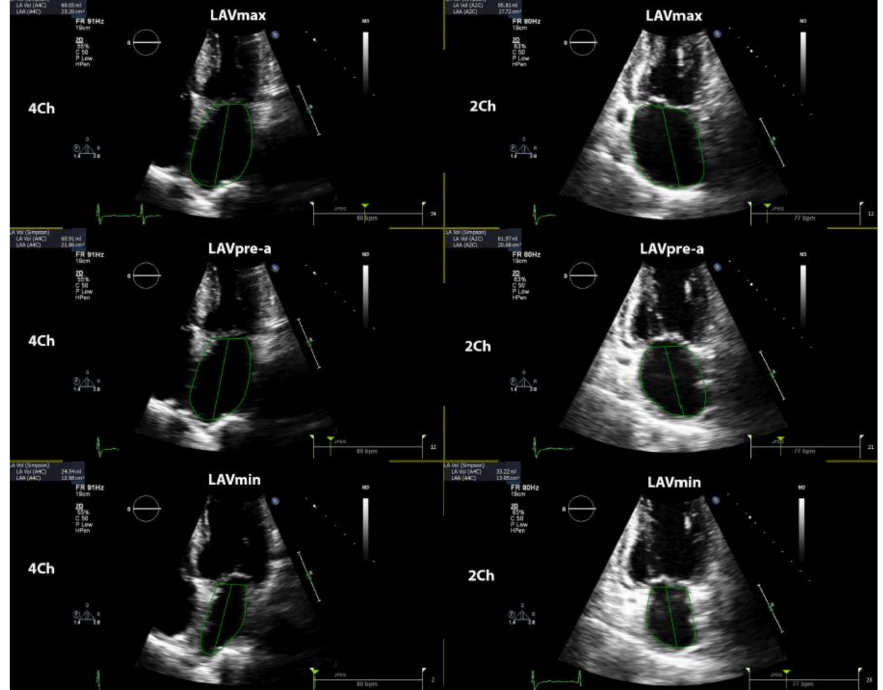
Figure 1. Shows the methodology of determination of left atrial volumes. LAV max —maximal left atrial volume; LAV min —minimal left atrial volume; LAV pre-a —left atrial volume before atrial